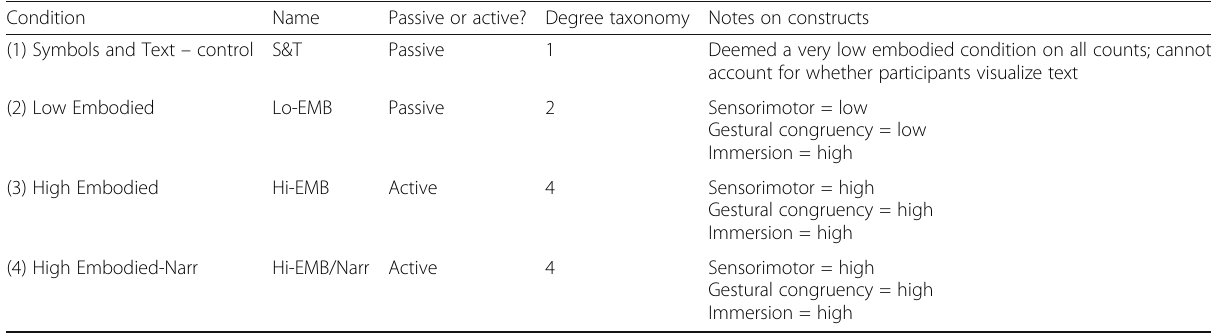
Table 2 Condition name and degree of embodiment in taxonomy